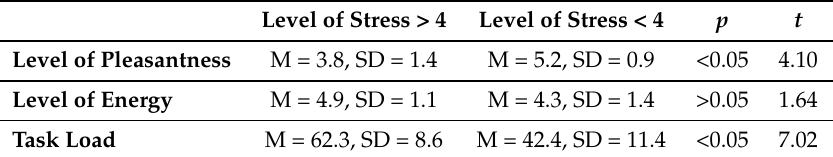
Table 4. Summary of level of pleasantness, energy level and task load.